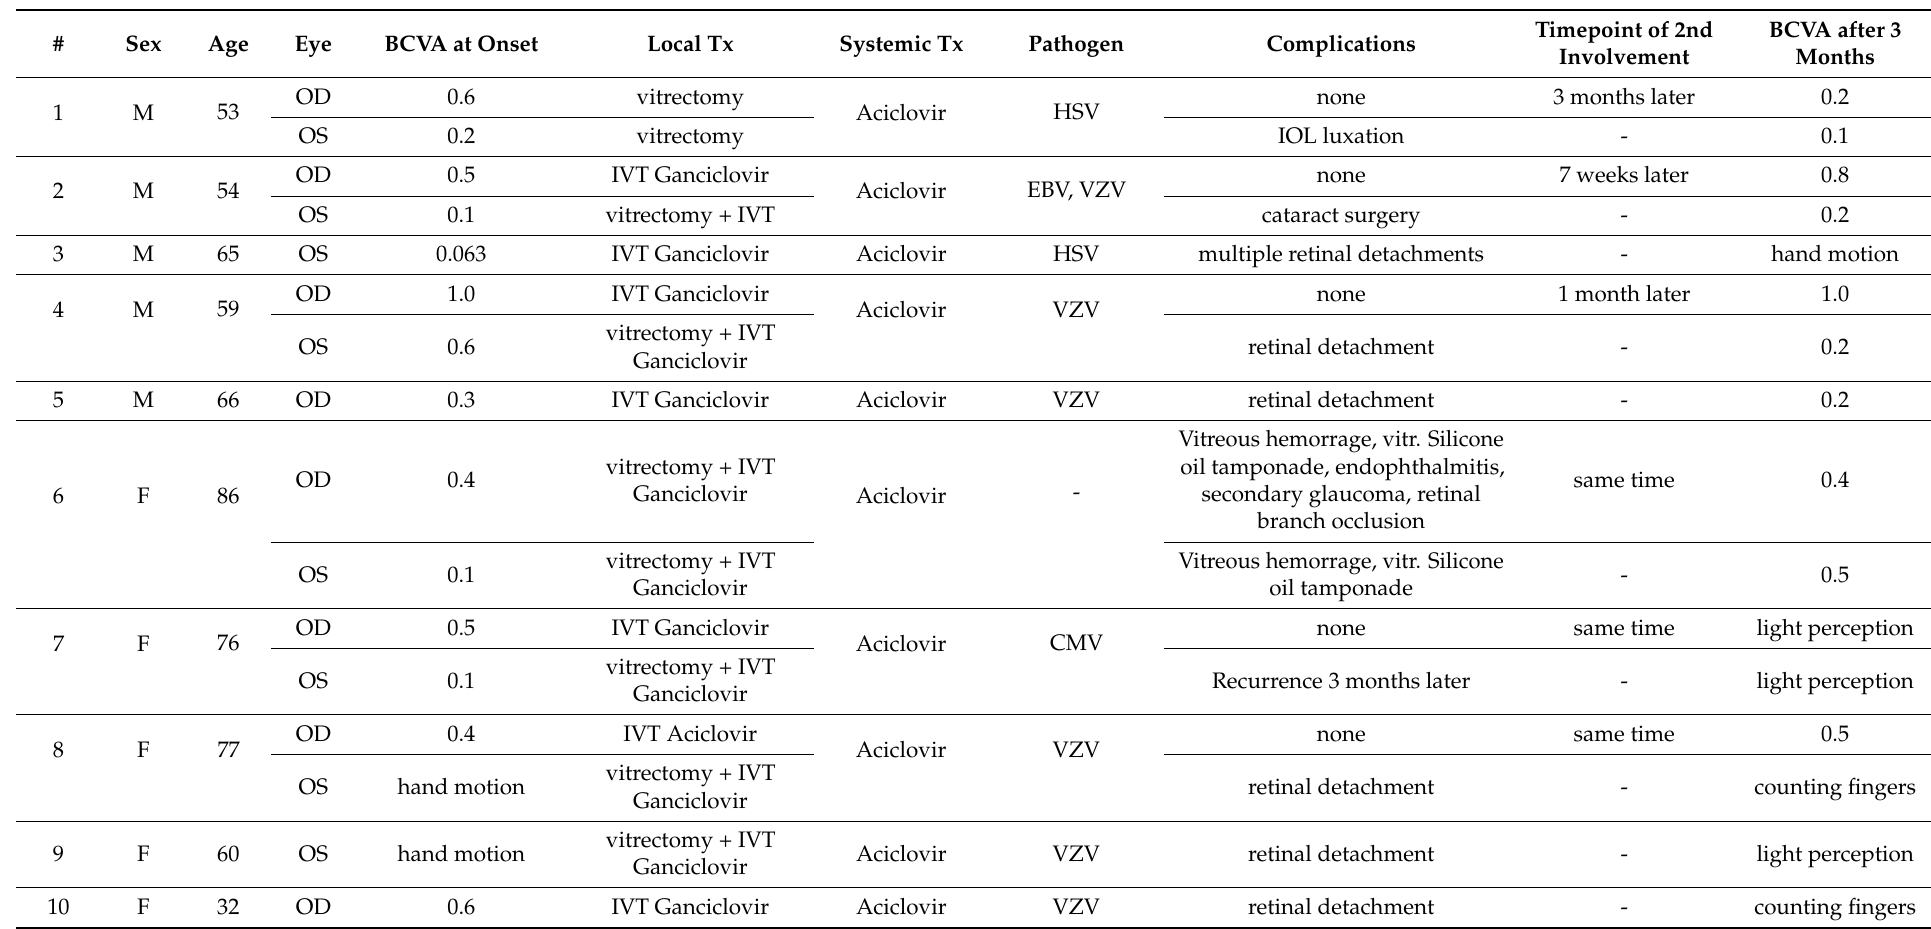
Table 1. Data of 10 patients and 16 eyes with ARN. Vitrectomy (vitr.), intravitreal injection (IVT), herpes simplex virus (HSV), varizella-zoster-virus